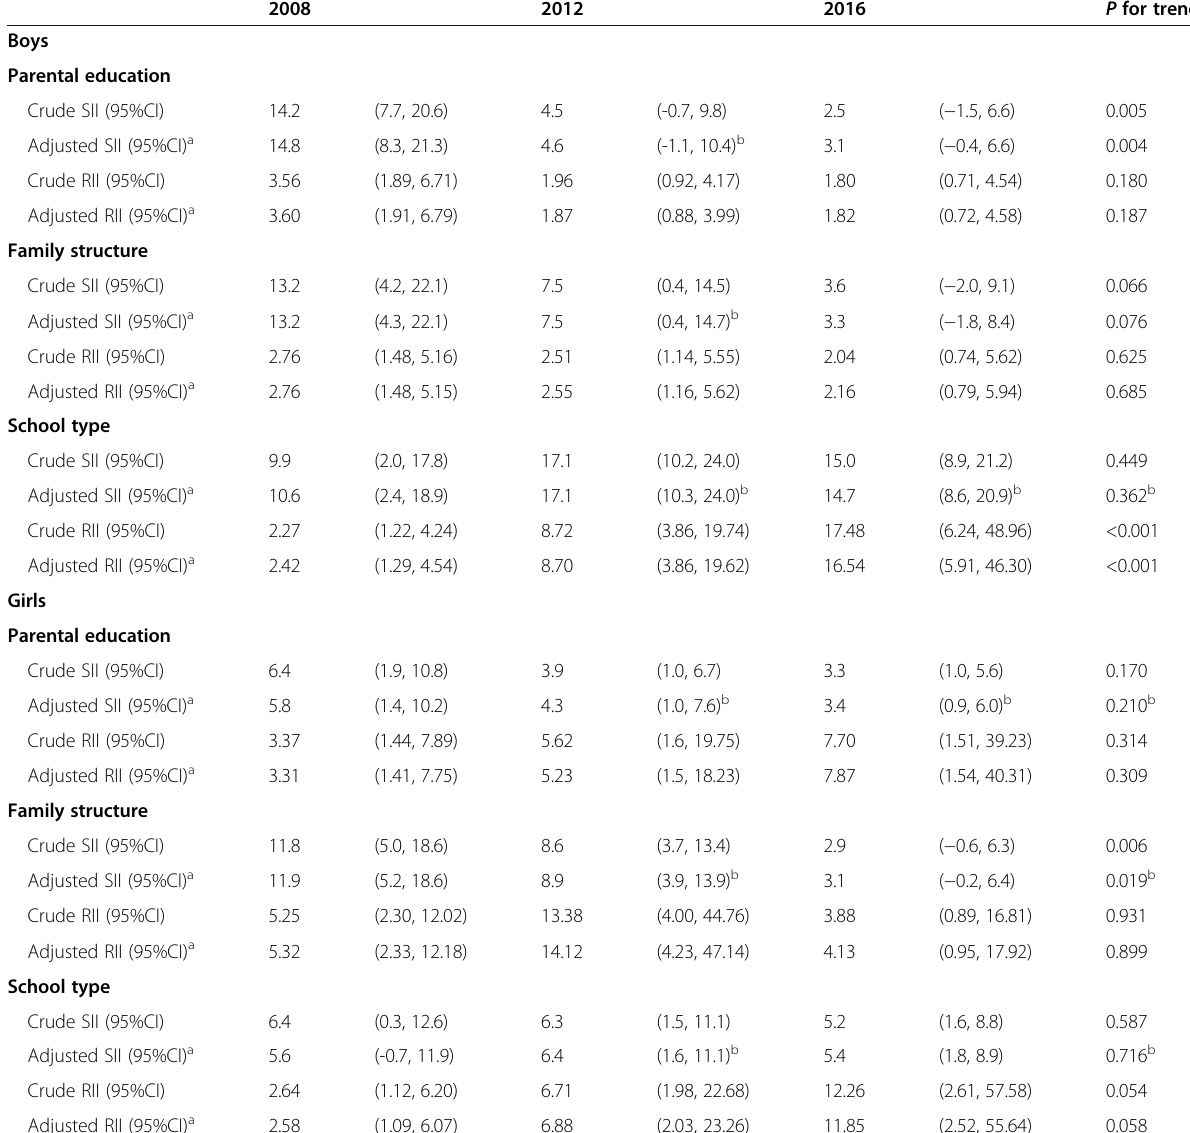
Table 4 Slope index of inequality (SII) and relative index of inequality (RII) in current smoking according to the SES indicators by survey year and sex 2008 2012 2016 P for trend